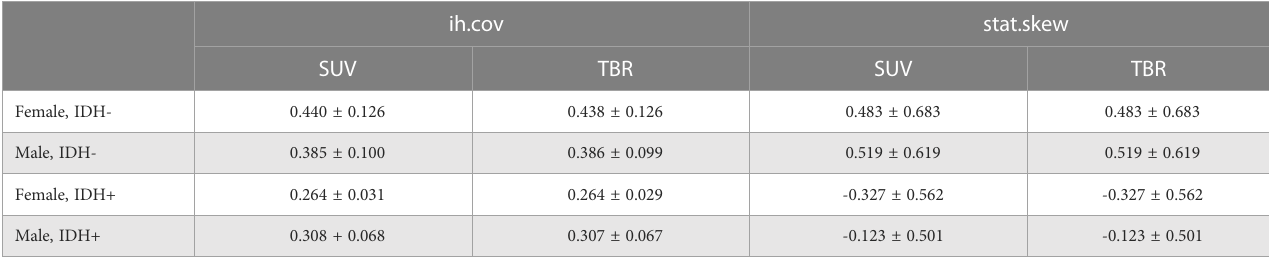
TABLE 4 Mean and standard deviation of histogram coef fi cient of variation (ih.cov) and intensity skewness (stat.skew) features in IDH+ and IDH- female and male patients in both SUV and TBR datasets. ih.cov